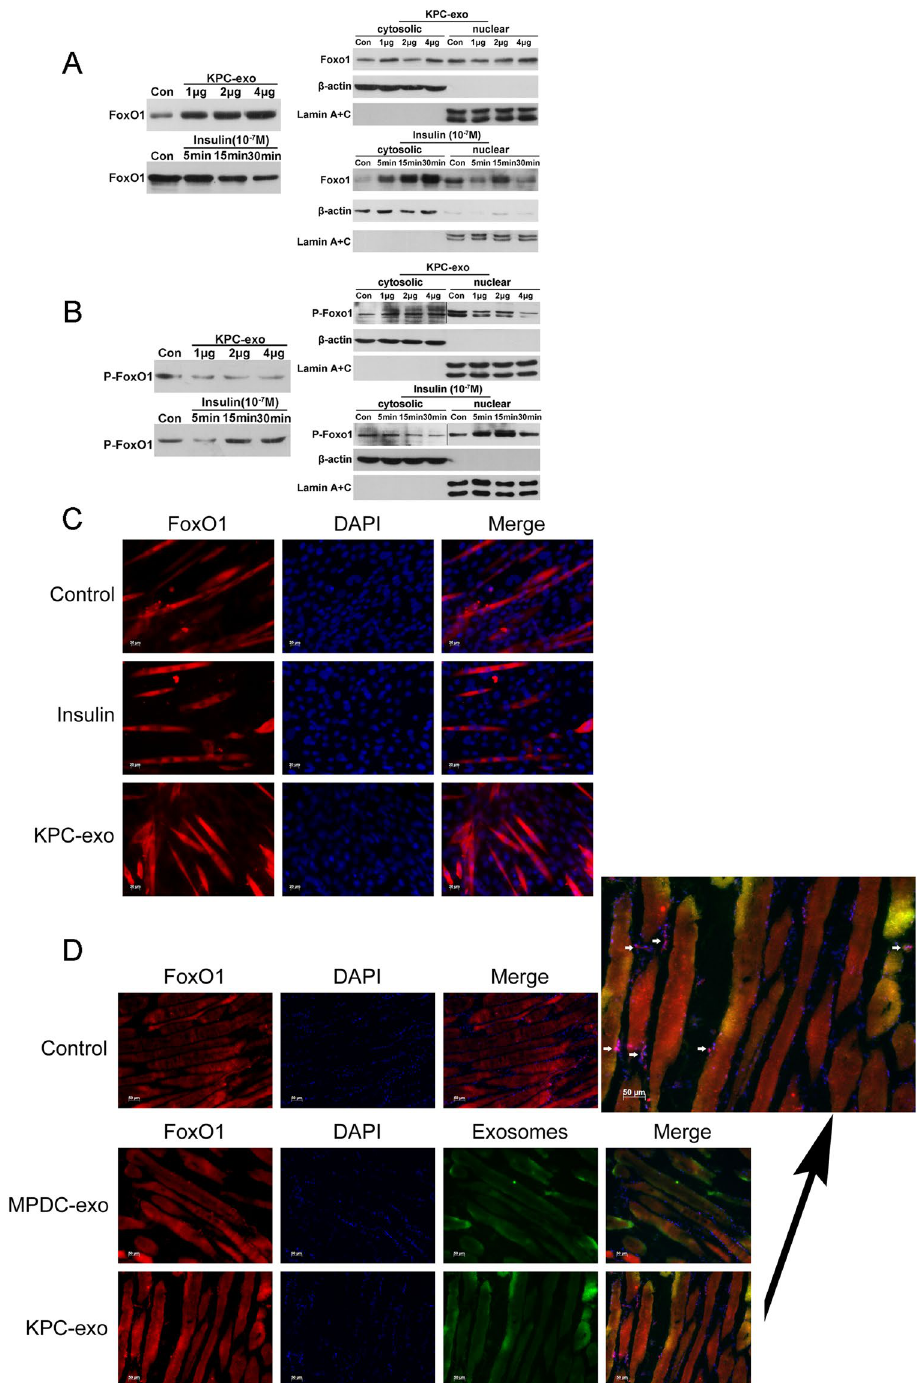
Figure 4. FoxO1 and Phospho-FoxO1 expression and nuclear translocation induced by KPC-exosomes in C2C12 myotubes. Differentiated C2C12 cells cultured in 25-cm 2 culture-flasks with 5 ml DMEM were treated with KPC-exosomes (1 μ g, 2 μ g, 4 μ g) for 24 h and 10 − 7 M insulin (5 min, 15 min, 30 min). ( A ) Total FoxO1 expression; expression in cytoplasm and nucleus. ( B ) Total Phospho-FoxO1 expression; expression in cytoplasm and nucleus. ( C ) Differentiated C2C12 cells cultured in 24-well plates were treated with 1 μ g/ ml KPC-exosomes for 24 h or 10 − 7 M insulin for 30 min. The nuclear (blue) translocation of FoxO1 (red) was verified by immunofluorescence. Scale bar, 20 μ m. ( D ) 20 μ g PKH67-dyed (green) exosomes in 100 μ L PBS was injected through the caudal vein into the body of each mouse. The nuclear (blue) translocation of FoxO1 (red) was verified by immunofluorescence. Scale bar, 50 μ